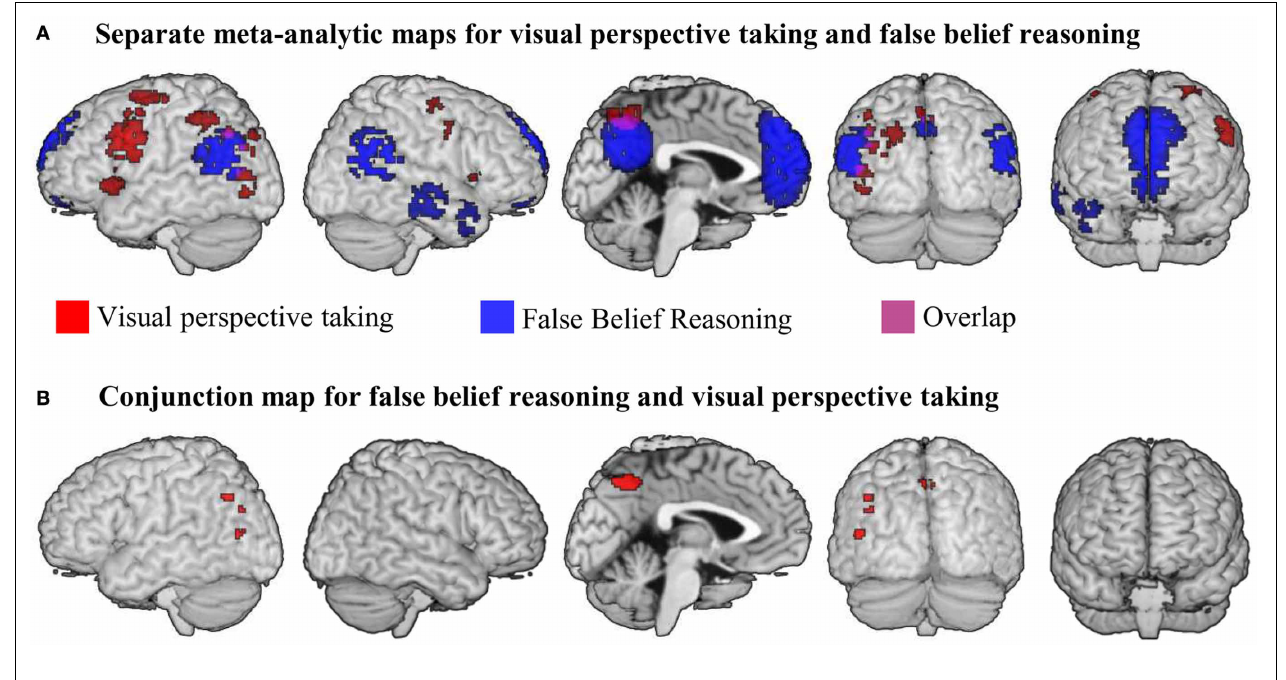
for false belief reasoning AND visual perspective taking. All maps were thresholded at voxel-wise threshold of p < 0 . 005 uncorrected and a cluster extent threshold 10